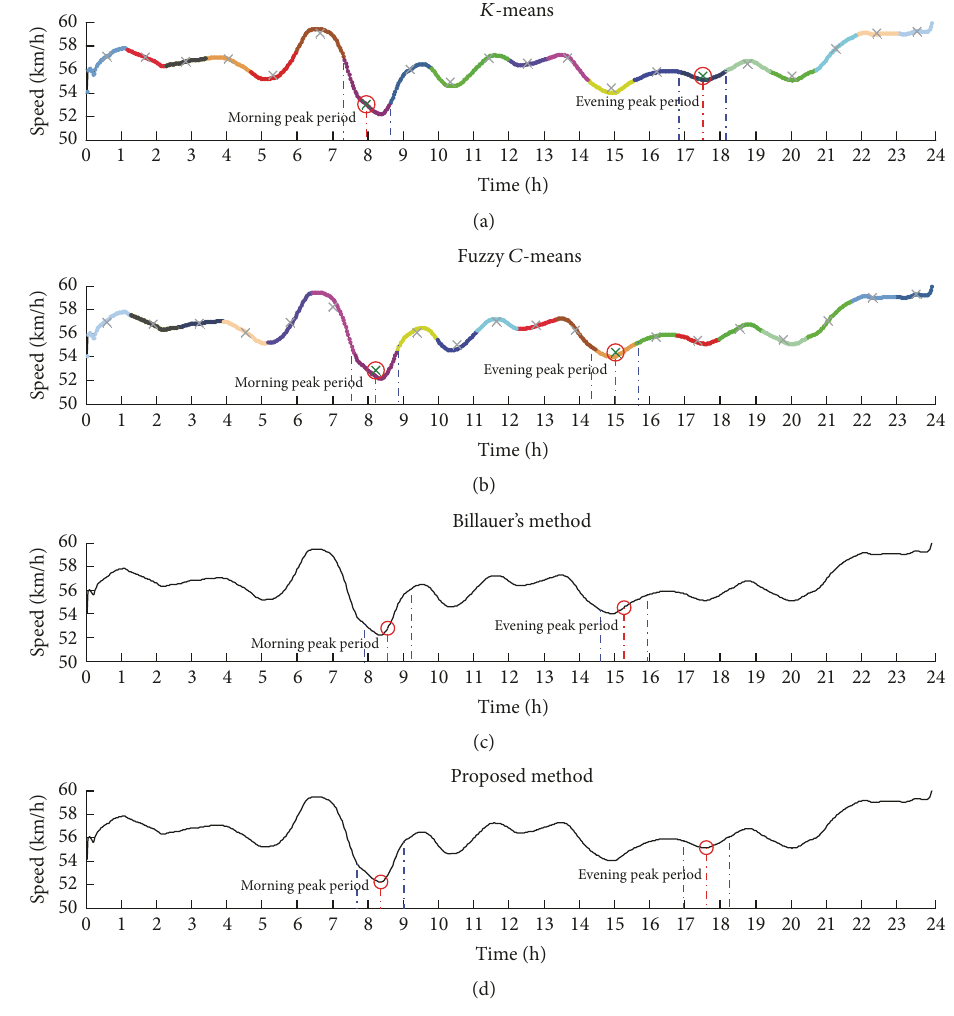
Figure 6: The detection results on Road